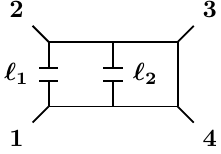
Figure 9 . Example of loop